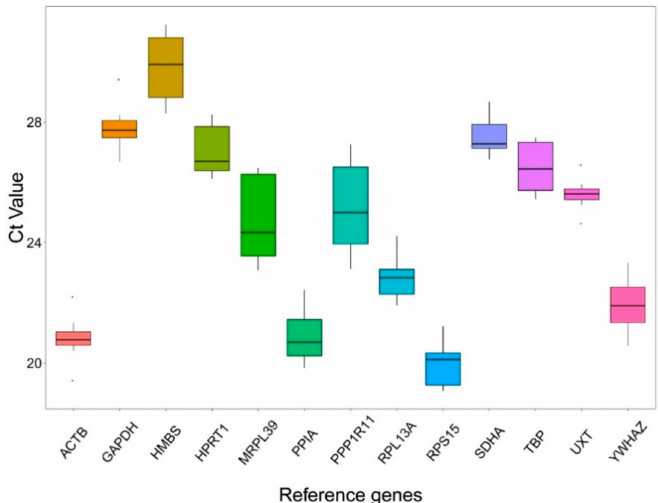
Figure 1. Ct values of 13 candidate RGs across all tested samples. The lower and upper box represents the 25th and 75th percentiles and the whiskers caps represent the maximum and minimum values. A center line across the boxes indicates the median.